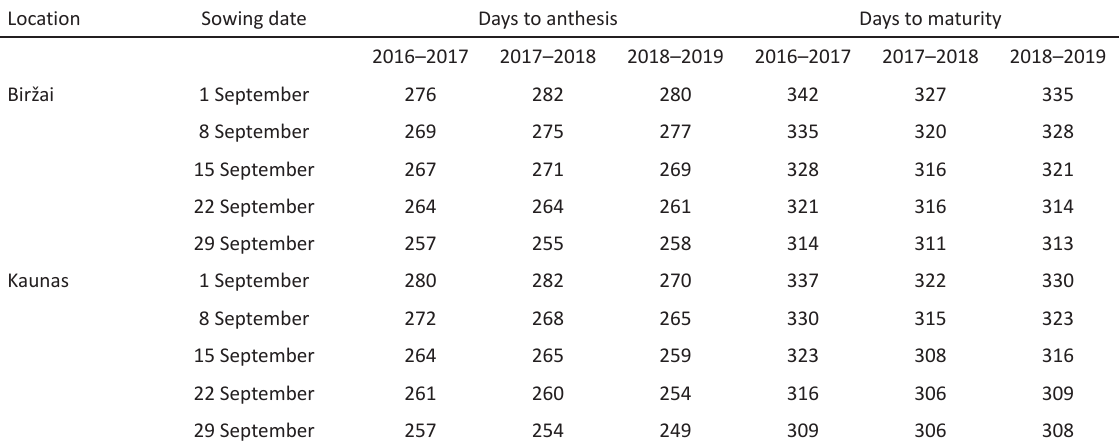
Table 7. Observed winter wheat phenological dates (DOY) from sowing to anthesis and maturity with different sowing times in three growing